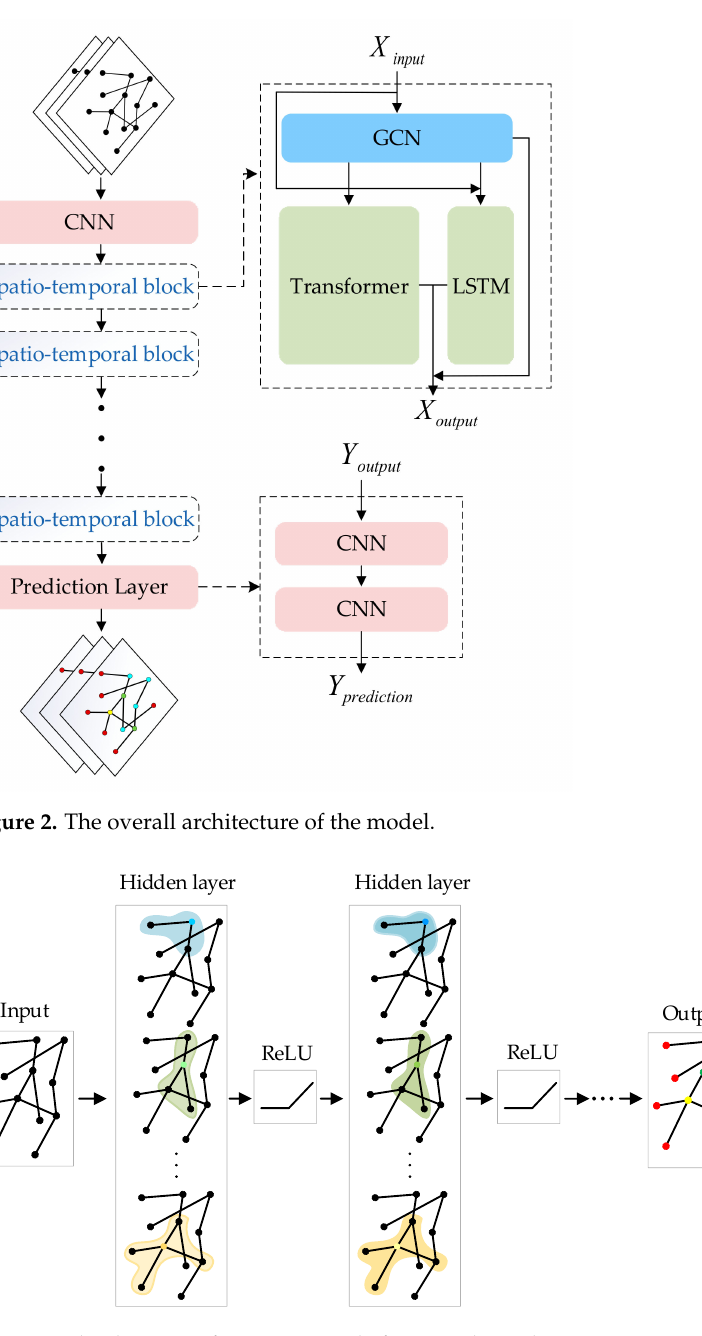
Figure 3. The diagram of capturing node features through GCN.